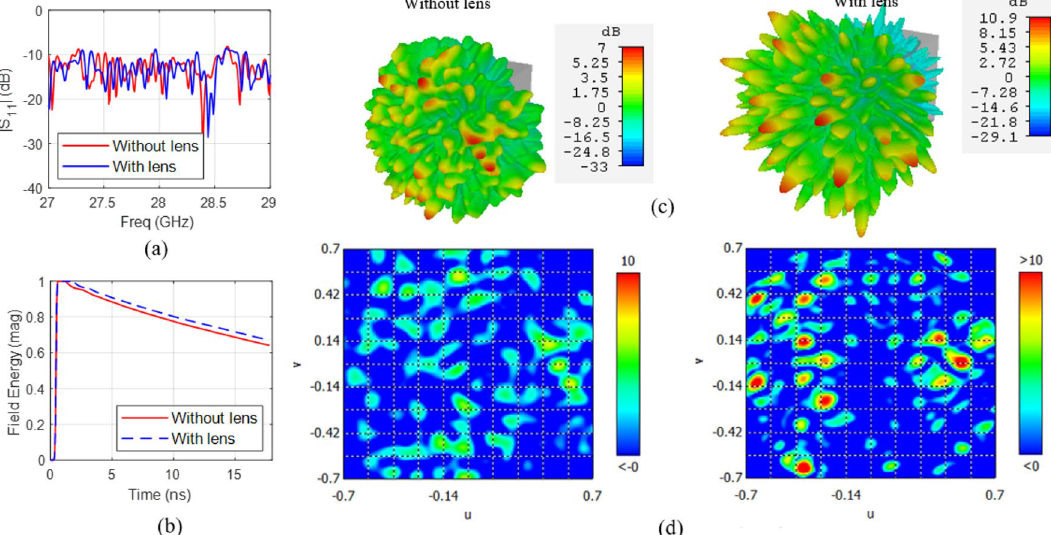
Figure 4. Simulation results of the lens-loaded cavity ( a ) matching, ( b ) energy decay profile and gain with and without the spherical constant- ϵ r lens ( c ) in the form of 3D radiation pattern, and ( d ) in uv -plane at 28